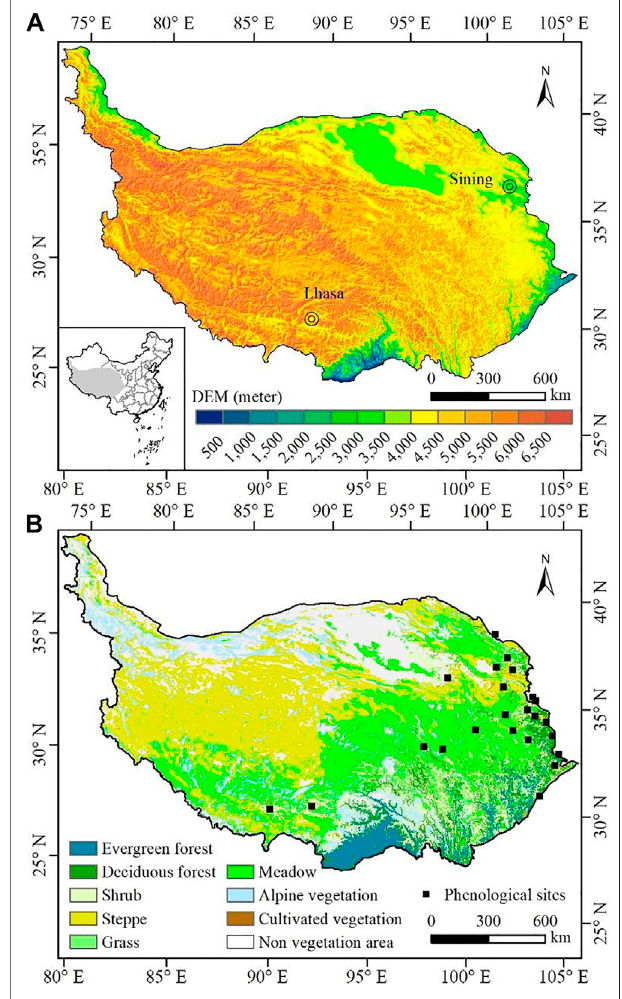
FIGURE1|(A) LocationoftheTibetanPlateau; (B) vegetation-typemap redrawn from 1:1,000,000 China vegetation data sets and location of phenological observation